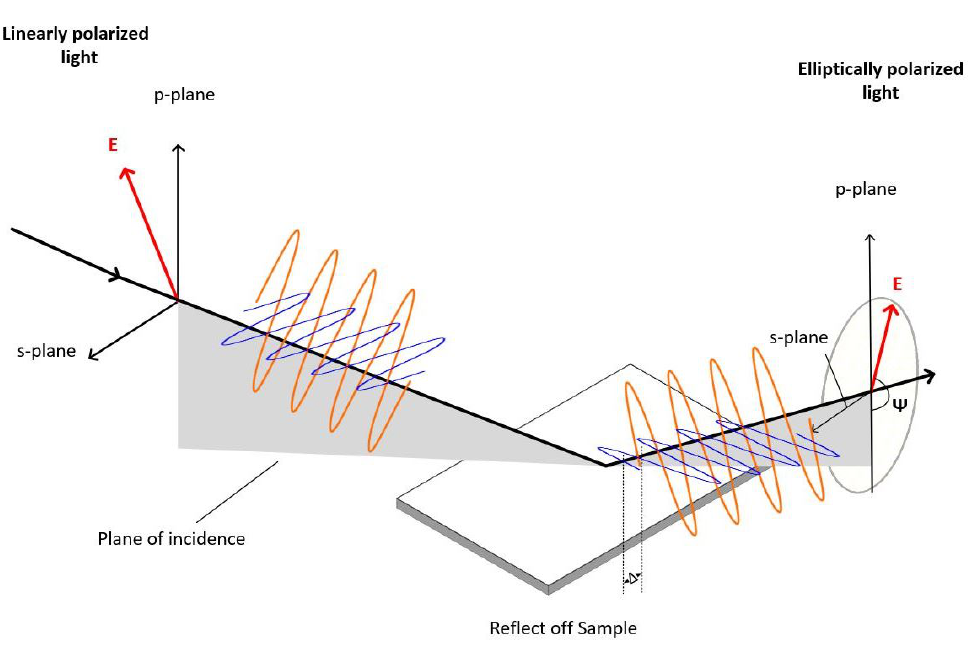
Figure 6. The ellipsometric experiment’s measurement geometry. In the p-s coordinate system, the coordinate system is used to describe the ellipse of polarization. The s direction is defined as parallel to the sample surface and perpendicular to the direction of propagation. The p direction is assumed to be perpendicular to the direction of propagation and lies inside the plane of incidence. The plane of incidence (gray area) is defined as the plane including the input and output beams and the direction which is normal to the sample